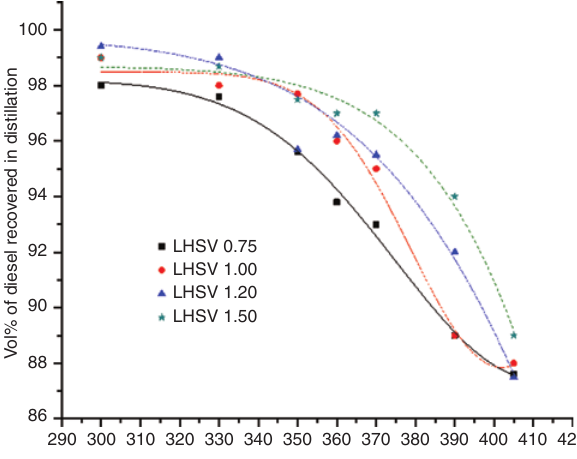
Figure 1: Volume % of gas oil recovered from the product by simple distillation on a cut point temperature 162 ° C. The distillate contains water and naphtha fractions (majority are C to C 16